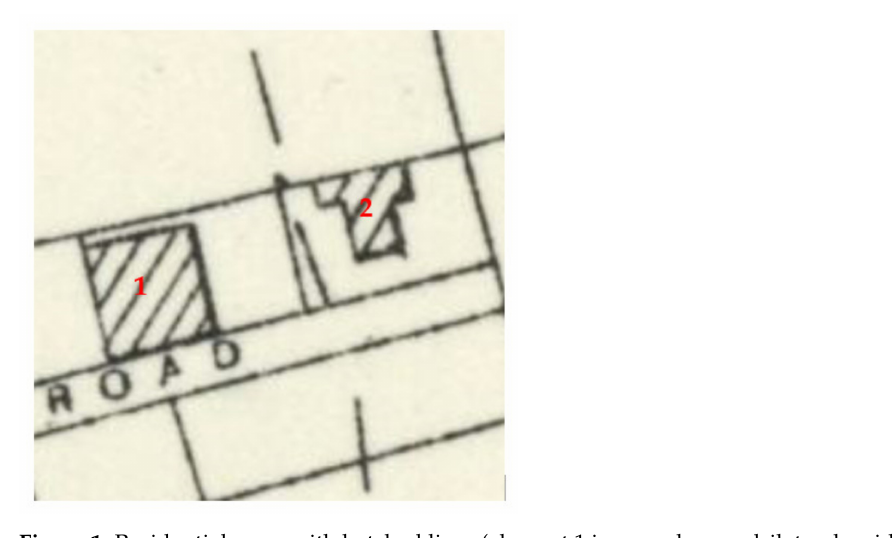
Figure 1. Residential areas with hatched lines (element 1 is a regular quadrilateral residential area and element 2 is an irregular polygonal residential